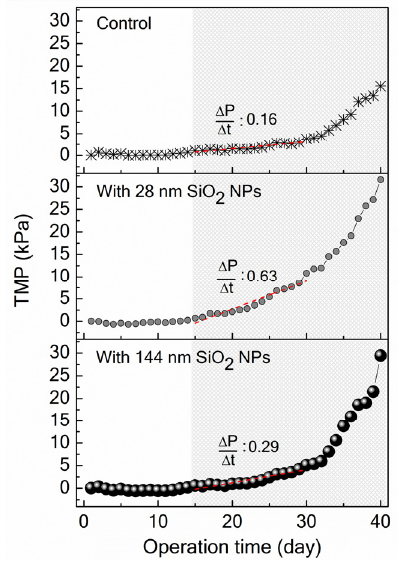
Figure 6. Effect of SiO 2 NPs on the evolution of transmembrane pressure (TMP) in an MBR. The shaded area indicates exposure to SiO 2 NPs.